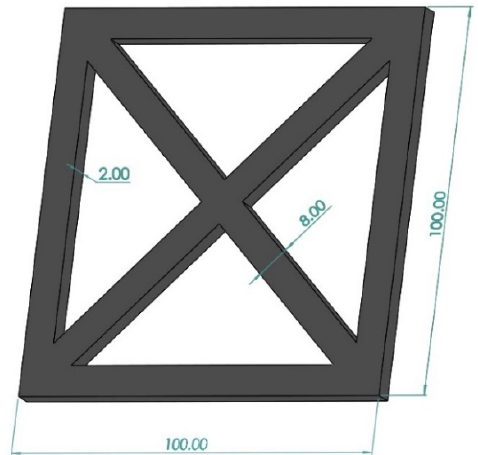
Figure 1. Part designed for warpage analysis. Its dimensions are given in mm.